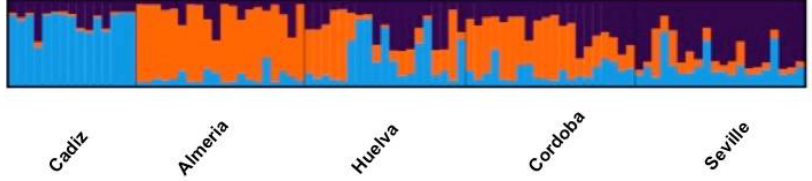
Figure 3. Plot of STRUCTURE results with K = 3 of Q. ilex populations from Andalusia. For the DAPC analyses, cross-validation indicated that 30 principal component (PC) axes and 4 DA axes were optimal. In the space of the first two DA axes, C á diz and Almer í a populations were divergent from one another and from the remaining populations that grouped together as partially overlapping clusters (Figure 4).